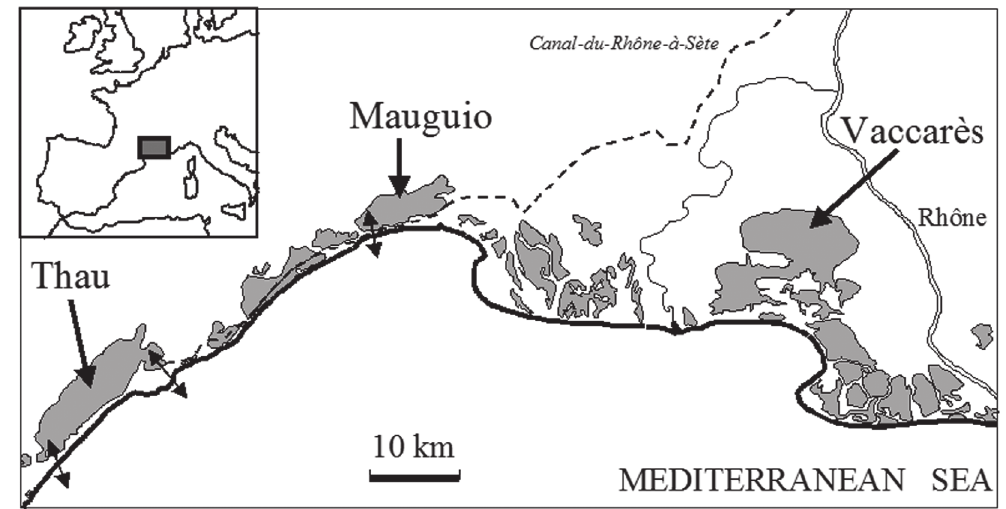
Fig . 1. – map of lagoons along the French mediterranean coast, including the Thau and mauguio